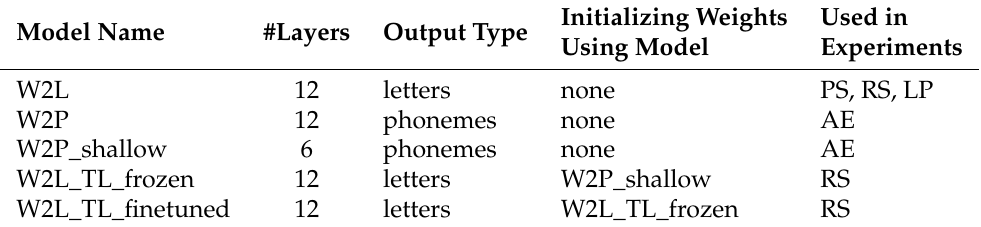
Table 2. Overview of models and which experiments they are used in. AE: Alignment Evaluation (Section 5.1), PS: Plotting SNAPs (Section 5.2), RS: Representational Similarity (Section 5.3), LP: comparing letter and phoneme representations (Section